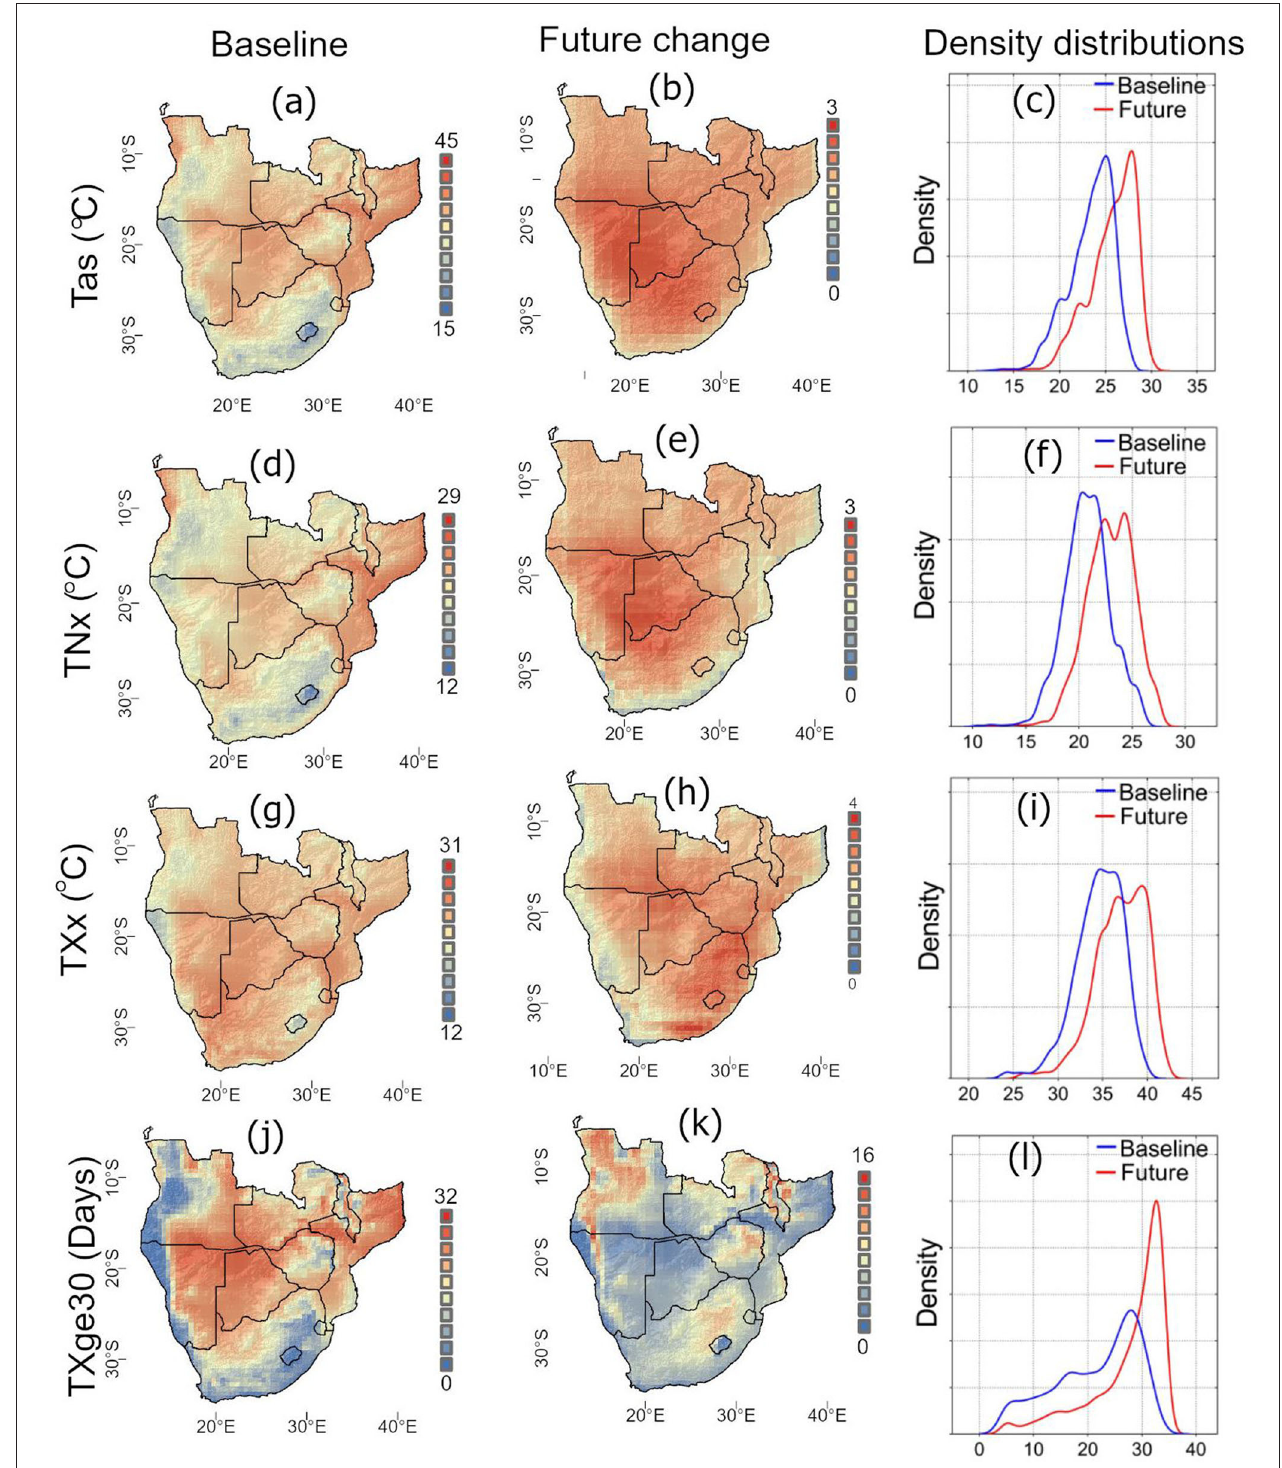
FIGURE 1 | The distribution of mean temperature and temperature indices under baseline and projected climate conditions for the agricultural season (October to April) over Southern Africa. First, second, third and fourth row show assessment of mean temperatures (Tas), maximum value of daily minimum temperature (TNx), maximum value of daily maximum temperature (TXx) and number of days when TX ≥ 30 ◦ C (TXge30), respectively. The first and second columns present the baseline (1986–2014) and the changes in the future (2036–2064) relative to the baseline, respectively. The third column show the area density plots to indicate the changes in area between the two climate